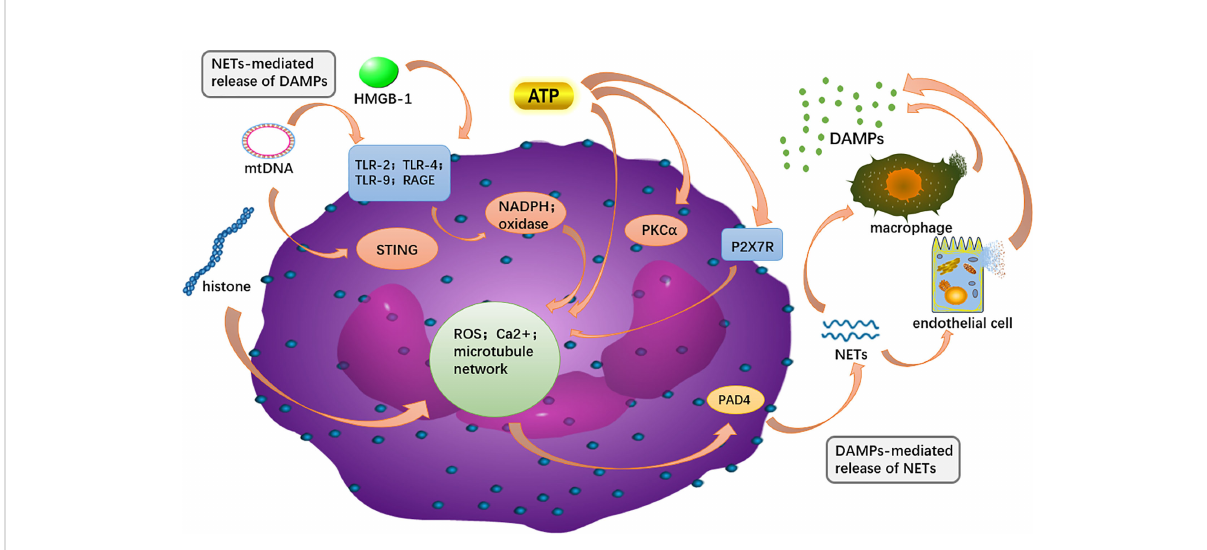
FIGURE 5 The intracellular DAMPs is released to the outside of the cell and can recognize PRR on surrounding neutrophils, and in turn, activate PAD4 to promote NET formation. NETs components, such as DNA and H3 histones, can further activate macrophages and endothelial cells, releasing more DAMPs out of the cell to amplify the in fl ammatory